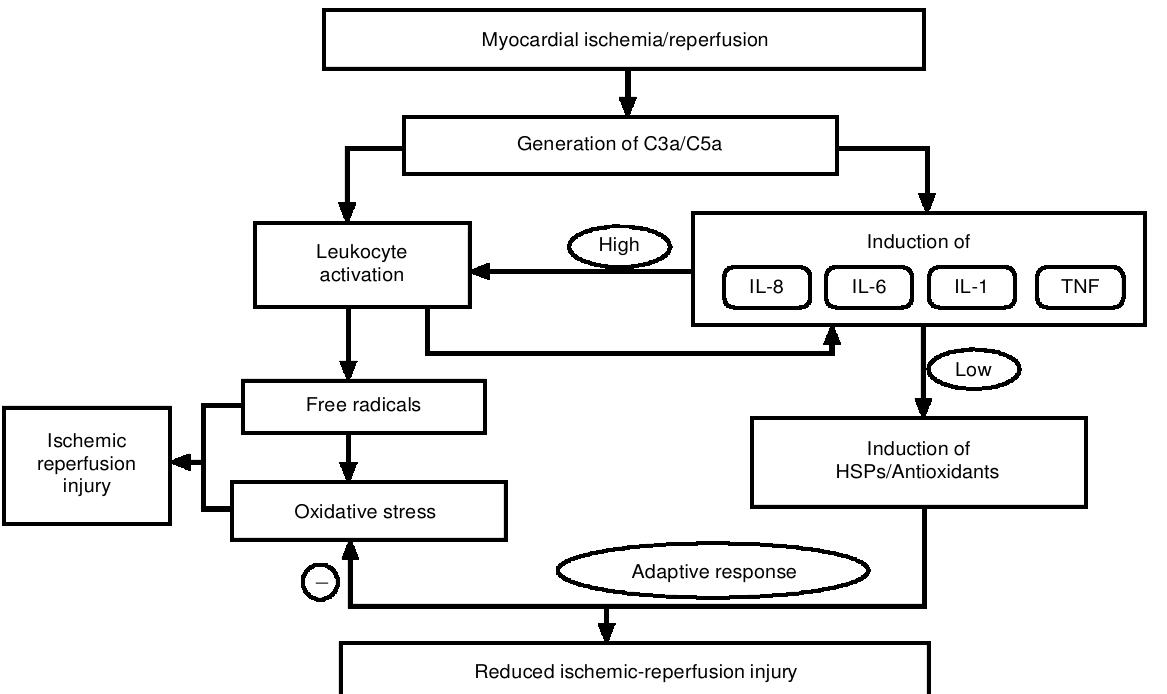
FIG. 1. A model of the role of cytokines in myocardial ischemia and